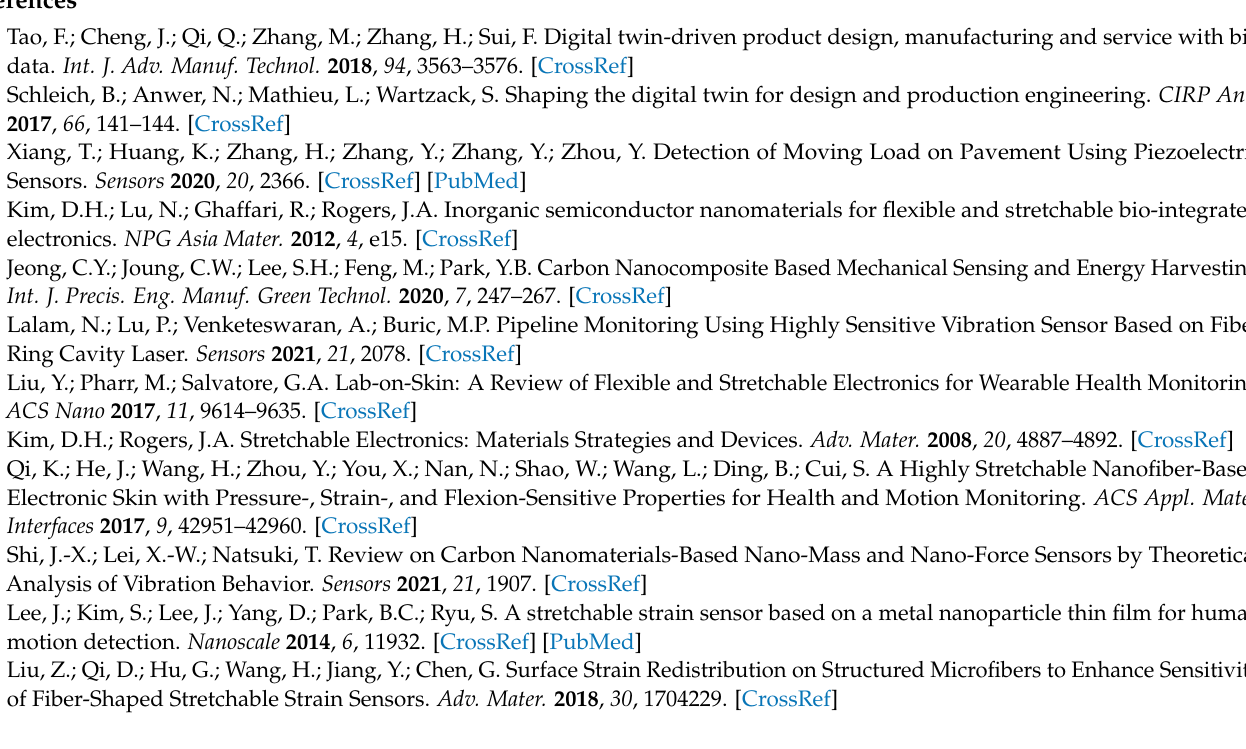
Table S5: The statistical results according to induced frequency with 400 Hz, Table S6: The statistical results according to induced frequency with 600